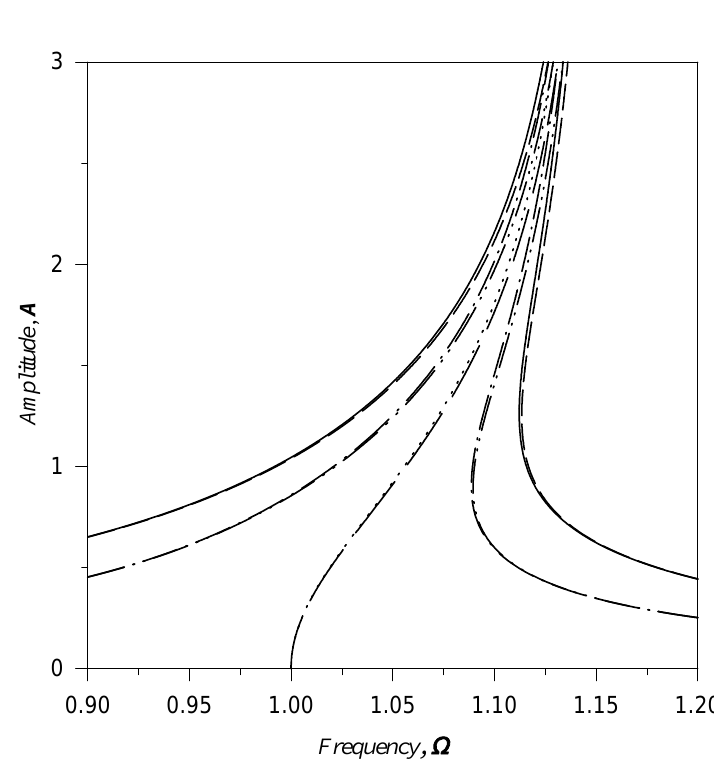
Fig. 8. Steady state frequency response of the wet and dry beam, for the case ε 1 = 1 . 0449 , ε 2 = 0 . 9329 , ε 3 c = 0 . 17974 , ε 3 d = 0 . 100623 , δ = 0 . 02 and P = 0 . 2 corresponding to the first mode of the wet beam and the case ε 1 = 1 . 050226 , ε 2 = 0 . 9329 , ε 3 c = 0 . 17974 , ε 3 d = 0 . 100623 , δ = 0 . 02 and P = 0 . 2 corresponding to the first mode of the dry beam system. – – – SHB-C Wet, —— SHB-C Dry, – –